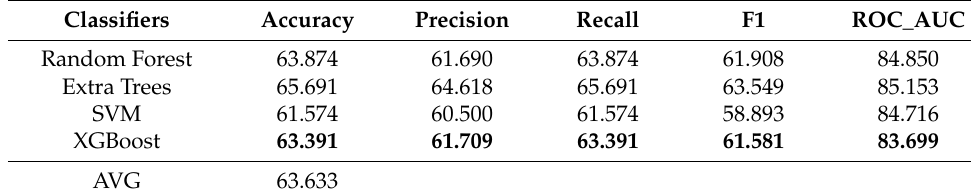
Table 6. Experimental Results using S_RNA with 1586 features.